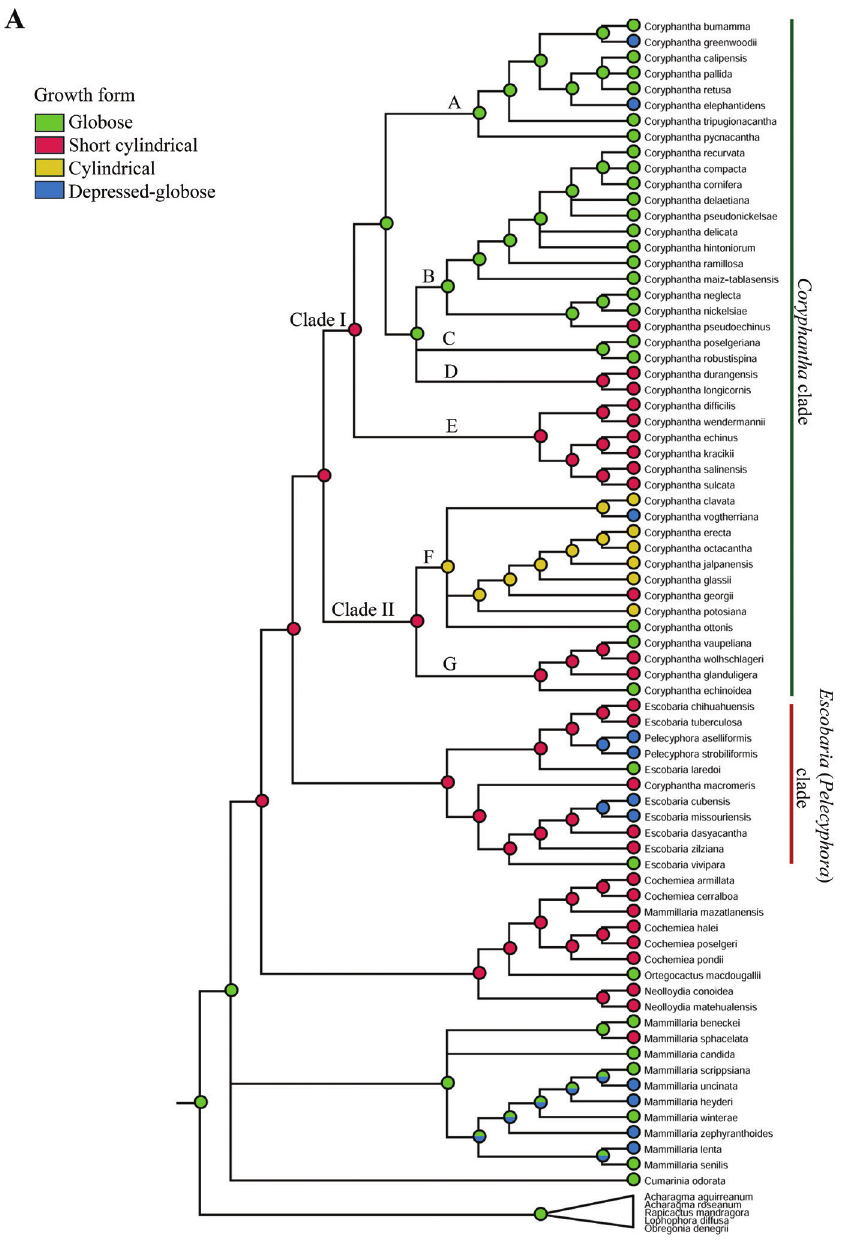
Figure A1. Ancestral states reconstruction in Coryphantha and related genera A growth form B groove on the tubercle in mature plant C extrafloral glands at or near the axil D position of the flowers E margin of the outer tepals F color of the mature fruit G type of cortex H multicellular sculpture of the lateral side of the